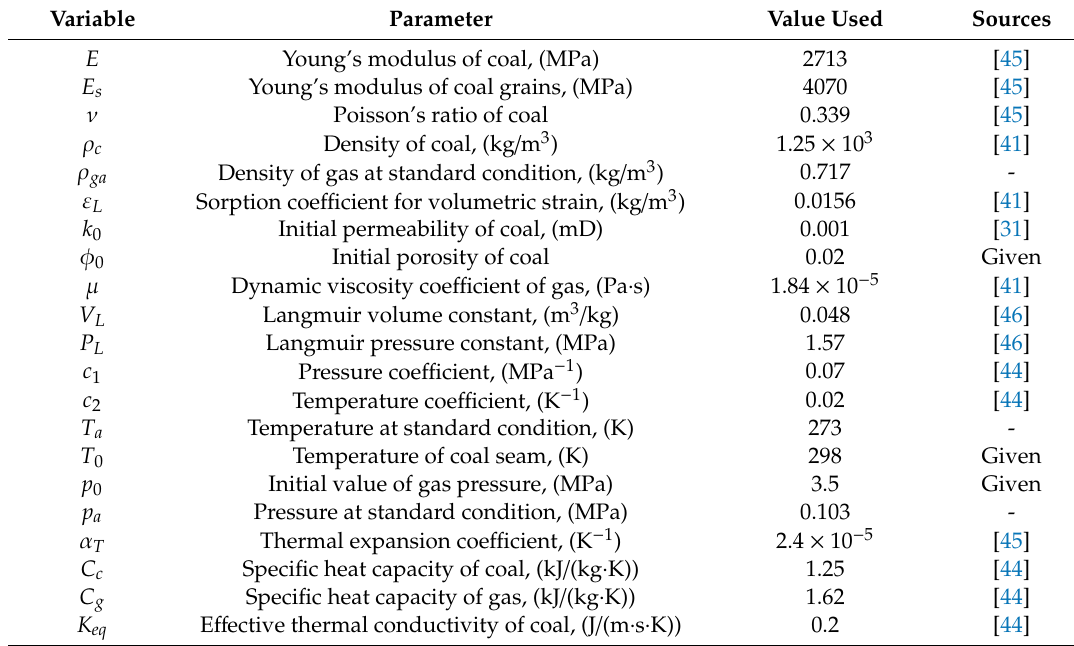
Table 2. Parameters used in simulation of coalbed methane thermal recovery.